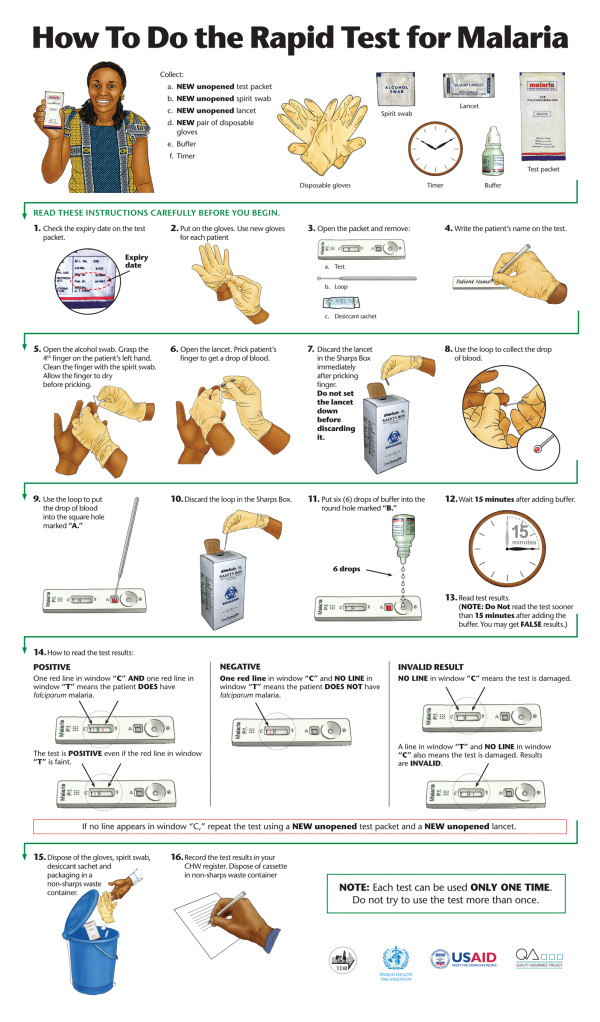
Final English version of the job aid for malaria RDT preparation. Actual size: 594 × 841 cm (A1 sheet)